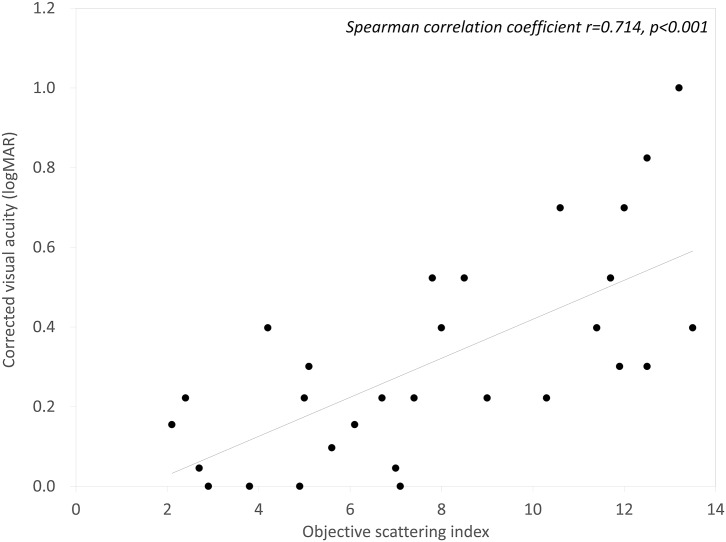
A graph showing a significant correlation between the objective scattering index (OSI) and best spectacle corrected visual acuity (BSCVA) (Spearman correlation coefficient r = 0.714, p<0.001).